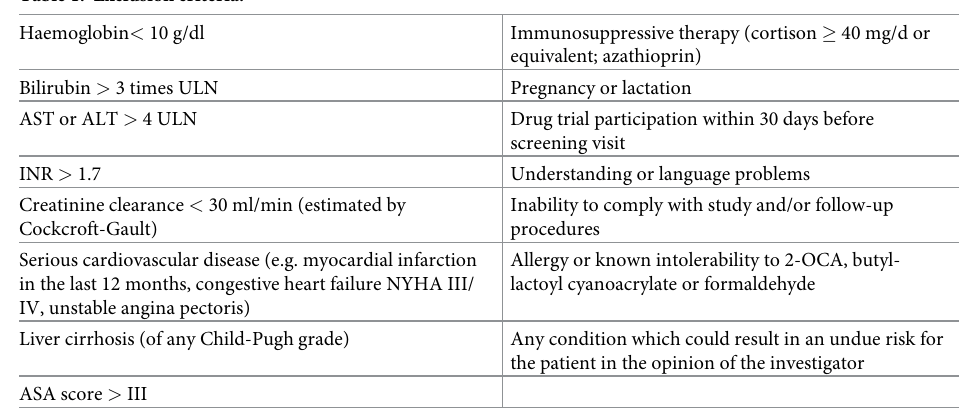
Table 1. Exclusion